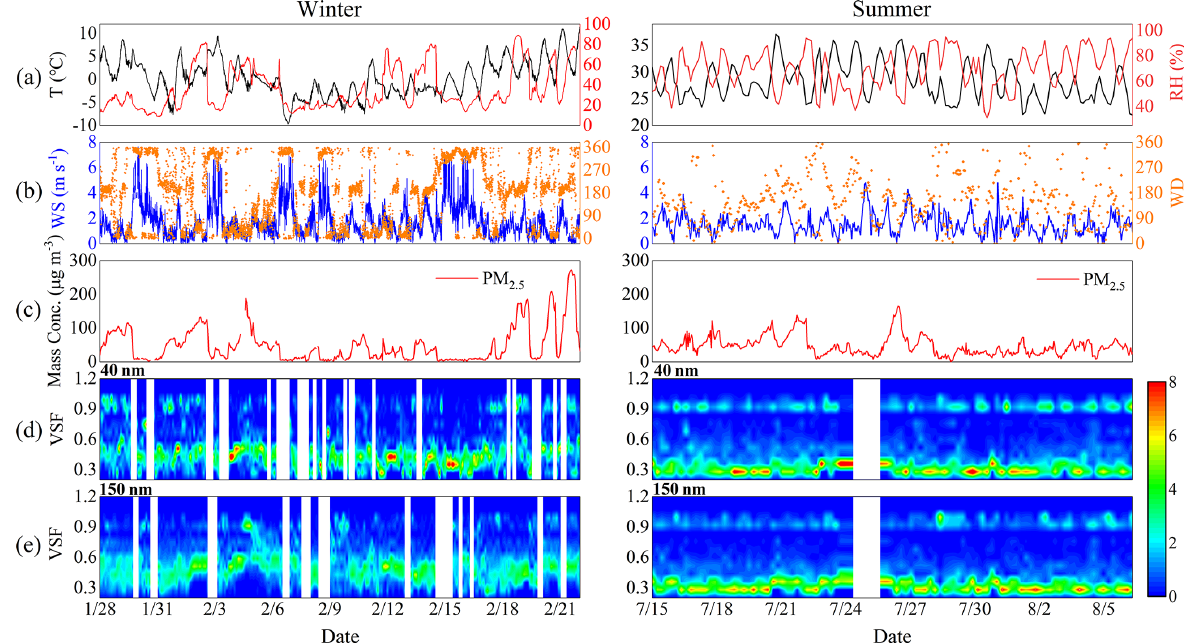
Figure 5. Time series of (a) ambient temperature ( T ) and relative humidity (RH), (b) wind direction and wind speed, (c) mass concentration of PM 2 . 5 , and (d–e) volatility shrink factor distributions (VSF-PDF) for 40 and 150nm particles at T = 300 ◦ during the winter (left) and summer (right)